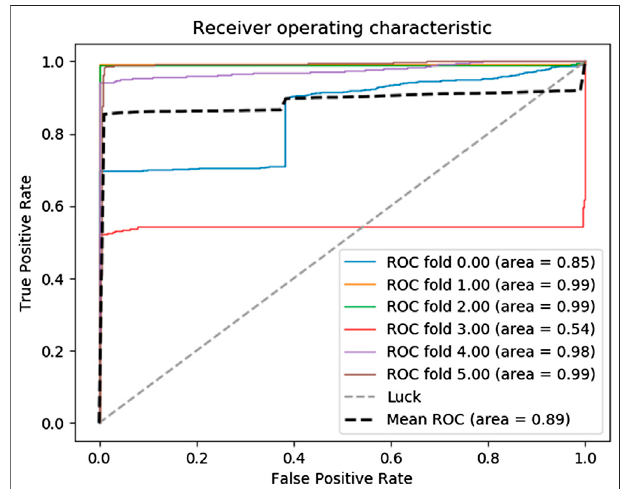
FIGURE 6 | Receiver operating characteristic of 16 dimensions.